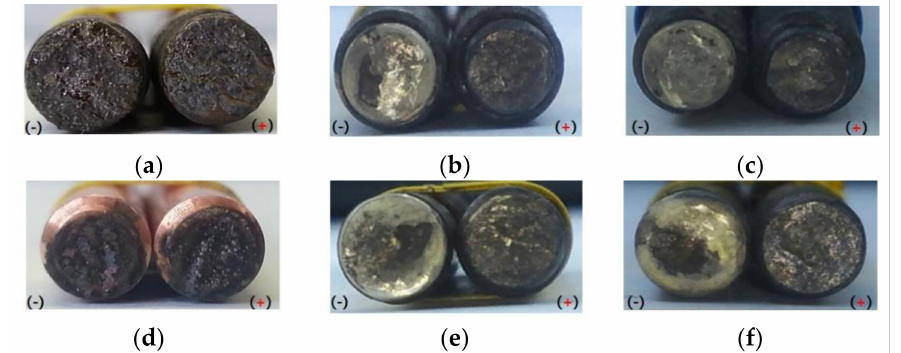
Figure 7. Contact surface condition of each electrode material in repeated operation 10,000 under 10 A load current condition; ( a ) AgW (failed after 1000 operations), ( b ) AgNi-Cu, ( c ) AgSnO2-Cu,